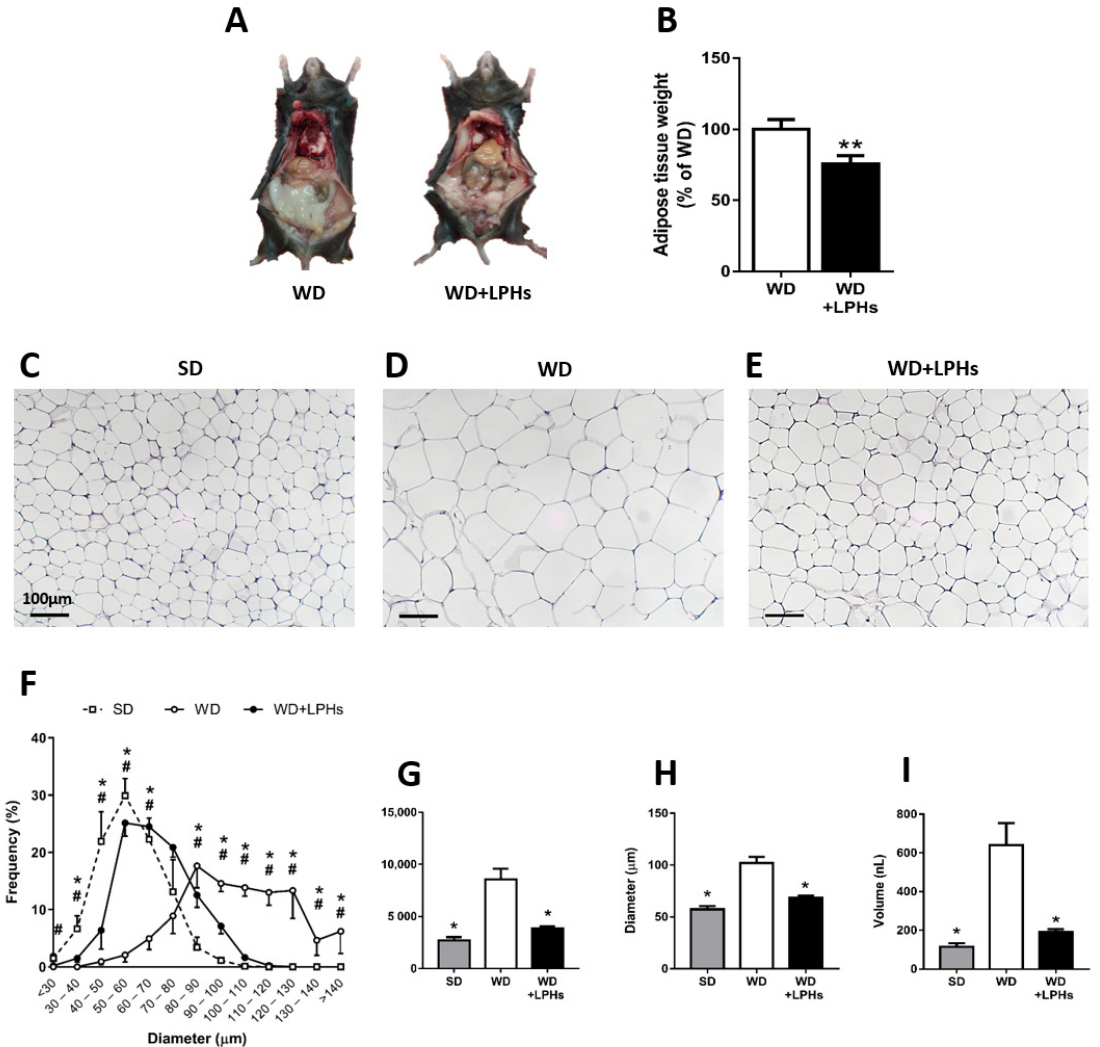
Figure 2. White adipose tissue analysis. Representative image of the abdominal WAT ( A ). White adipose tissue quantification ( B ) ( n = 30). Representative images of hematoxylin/eosin staining of WAT from SD ( C ), WD ( D ), and WD+LPHs ( E ) groups. Frequency of mean adipocyte size ( F ), mean adipocyte area ( G ), diameter ( H ), and volume ( I ). Values are shown as the mean and the standard error of the mean of each group. * p ≤ 0.05 respect to the WD group. ** p ≤ 0.01 respect to the WD group. In ( F ), # p ≤ 0.05 between SD and WD, * p ≤ 0.05 between WD and WD+LPHs. SD, standard diet group; WD, western diet group; WD+LPHs, western diet + lupin protein hydrolysates group.